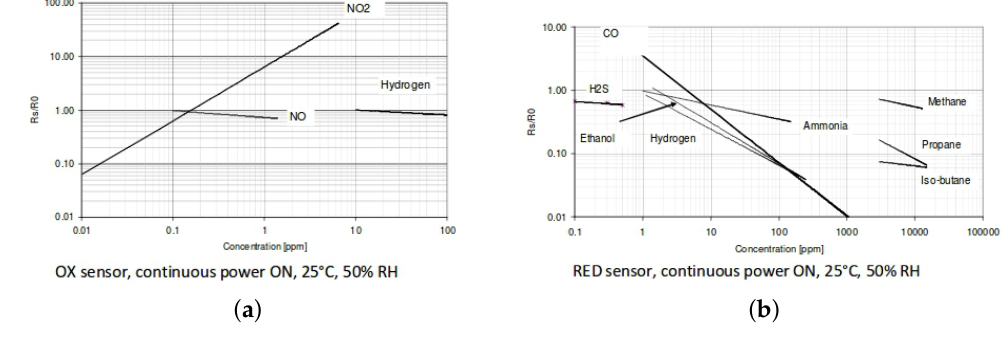
Figure 2. ( a ) MICS-4514 oxidising (OX) gas sensor element nonlinear response to nitrogen dioxide, from the manufacturer’s datasheet [37]; ( b ) MICS-4514 reducing (RED) gas sensor element response to various gases. R s is the sensor’s actual resistance, compared to the base resistance R 0 . Reproduced with permission from SGX